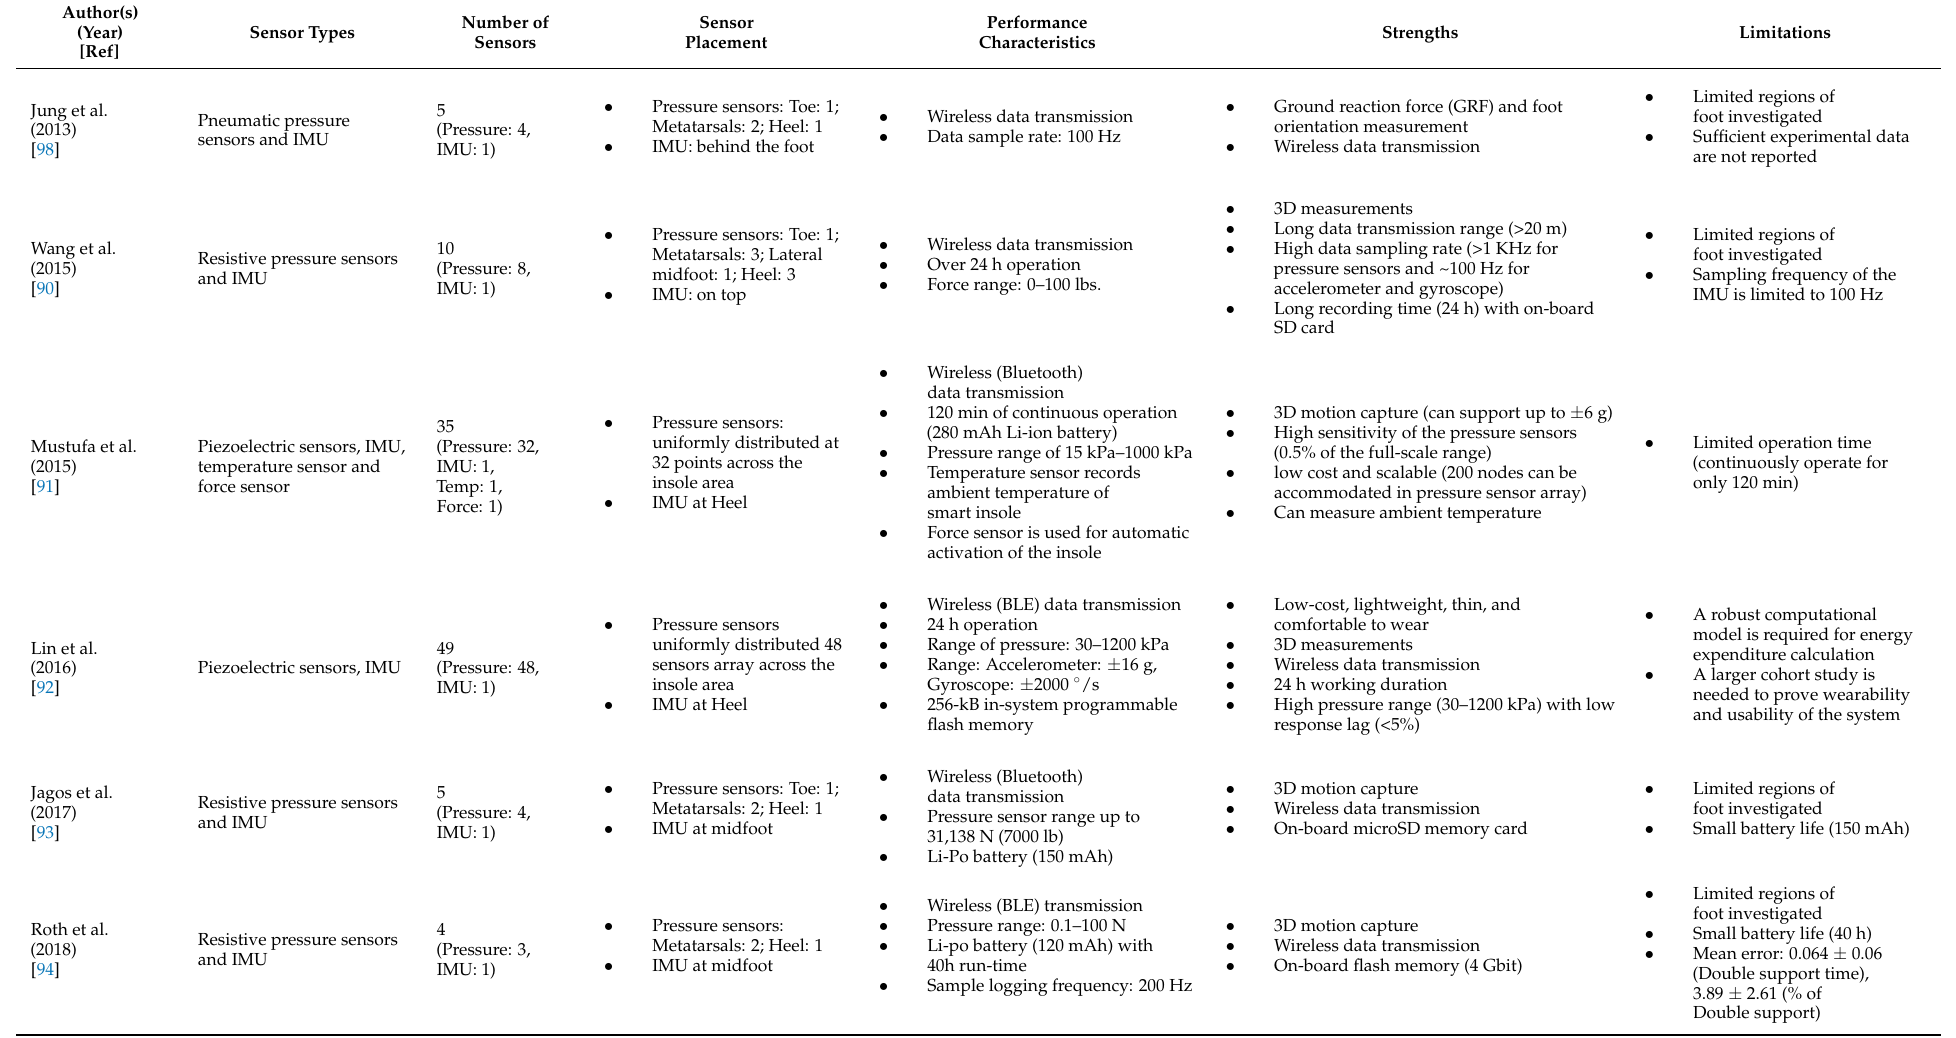
Table 3. Key points pertaining to various existing insole-based sensor systems used for gait and activity